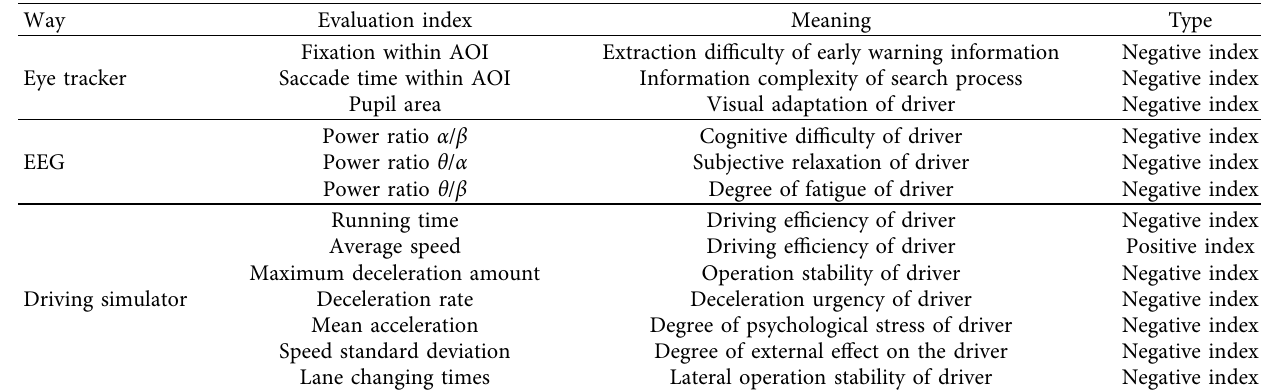
Table 4: Test evaluation